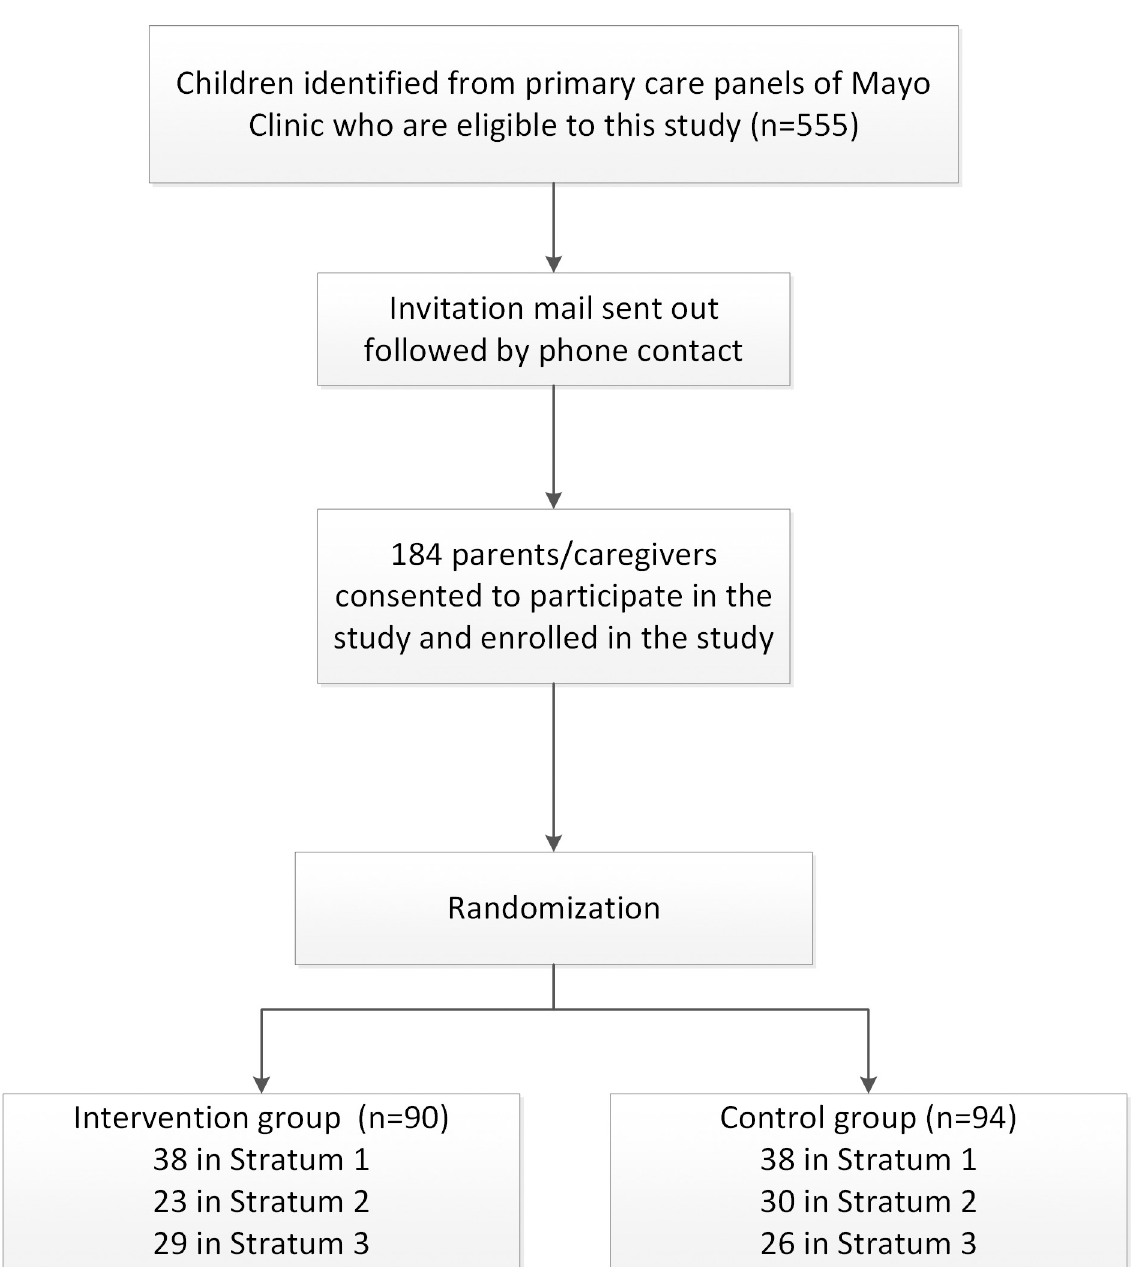
Fig 3. Consort flow diagram for subject enrollment and random allocation of subjects in each stratum to intervention vs control group (see Fig 1 for randomization, intervention and follow up). https://doi.org/10.1371/journal.pone.0255261.g003 5 referrals to community health workers (vs. 0), requests for 8 skin tests (vs. 5), 23 spirometry (vs, 12), 33 asthma-specific regular visits (vs. 4), and 28 ACT update (vs. 7)), of which were exe- cuted by asthma care team, compared to control group. The main results on the comparison in primary outcomes between the intervention and control groups are summarized in Fig 4 and Table 2.